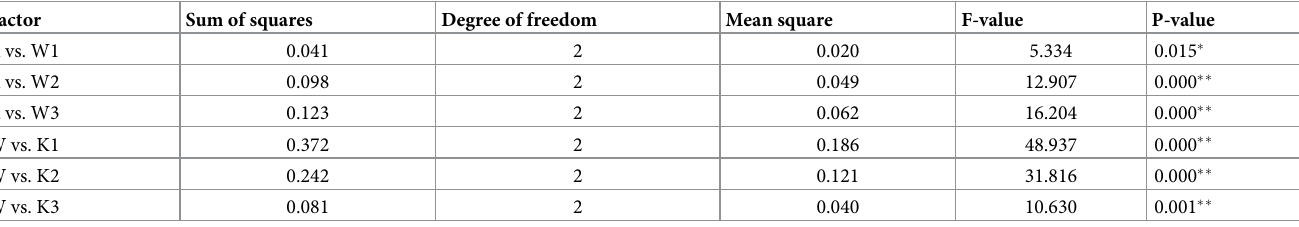
Table 2. Single effect of soil moisture level or K fertilizer rate during the fruit maturity stage on tomato yield. Factor Sum of